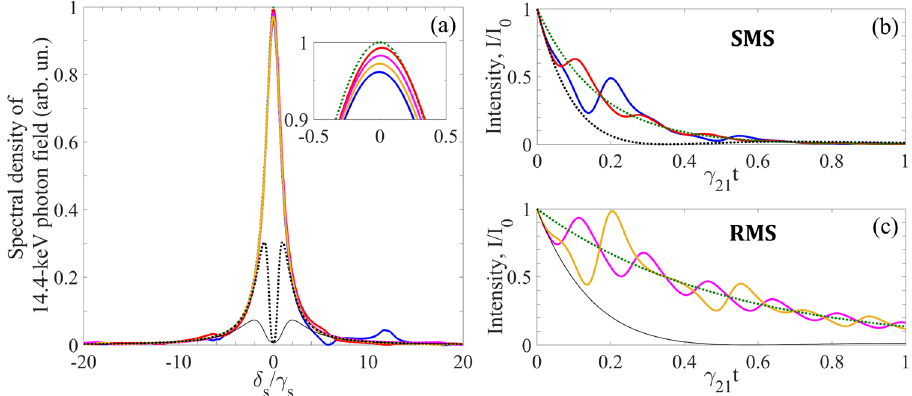
10.2 MHz ( 2 π) ≈ 3 γ 21 , blue and S = (cid:31) 0 and